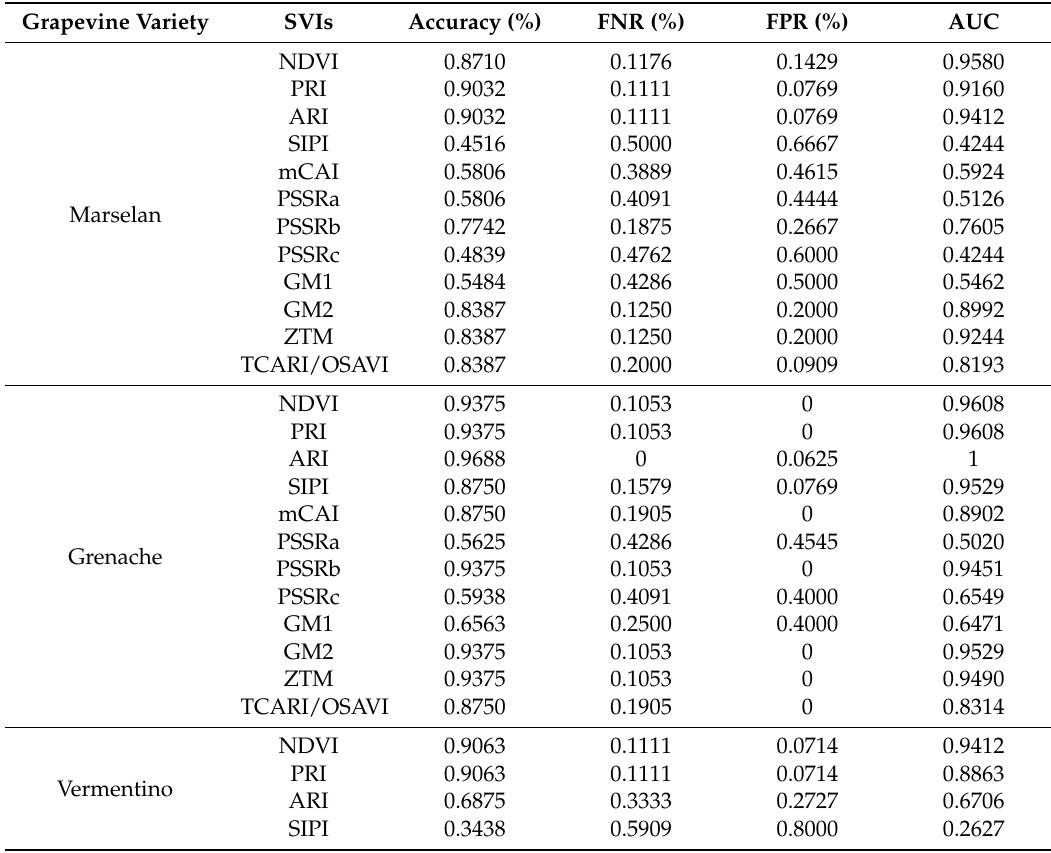
Table A1. Results of SVIs in classifying different groups of spectral data acquired in the August acquisition campaign (Severity of infestation =